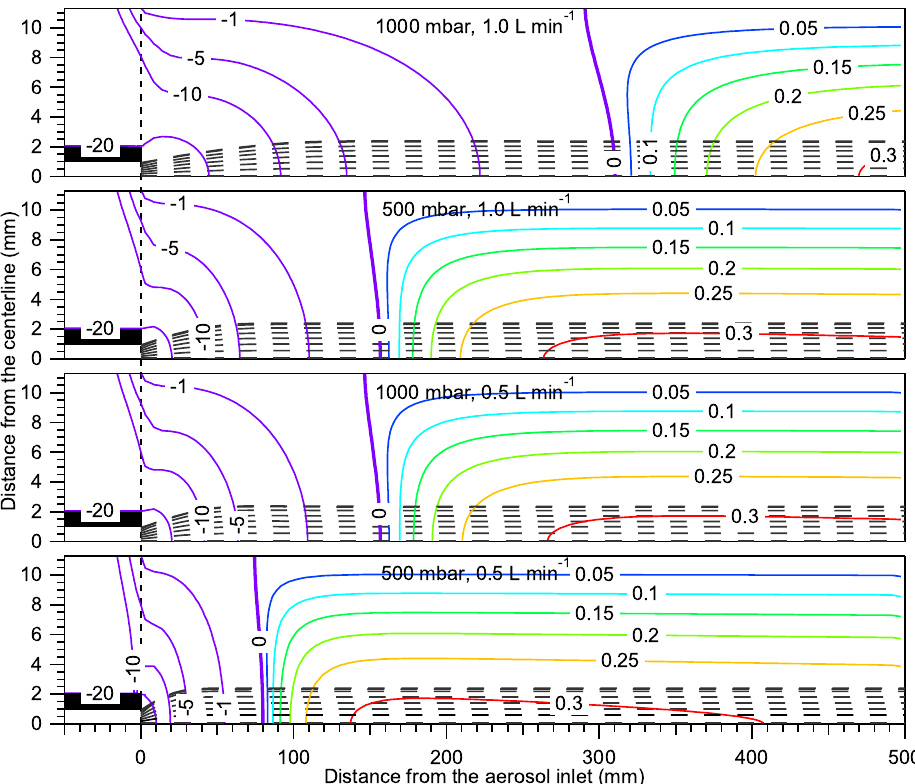
Fig. 7. Calculated supersaturation fields from the long model (colored contour lines and labels in%) and trajectories for aerosol sections (dashed black